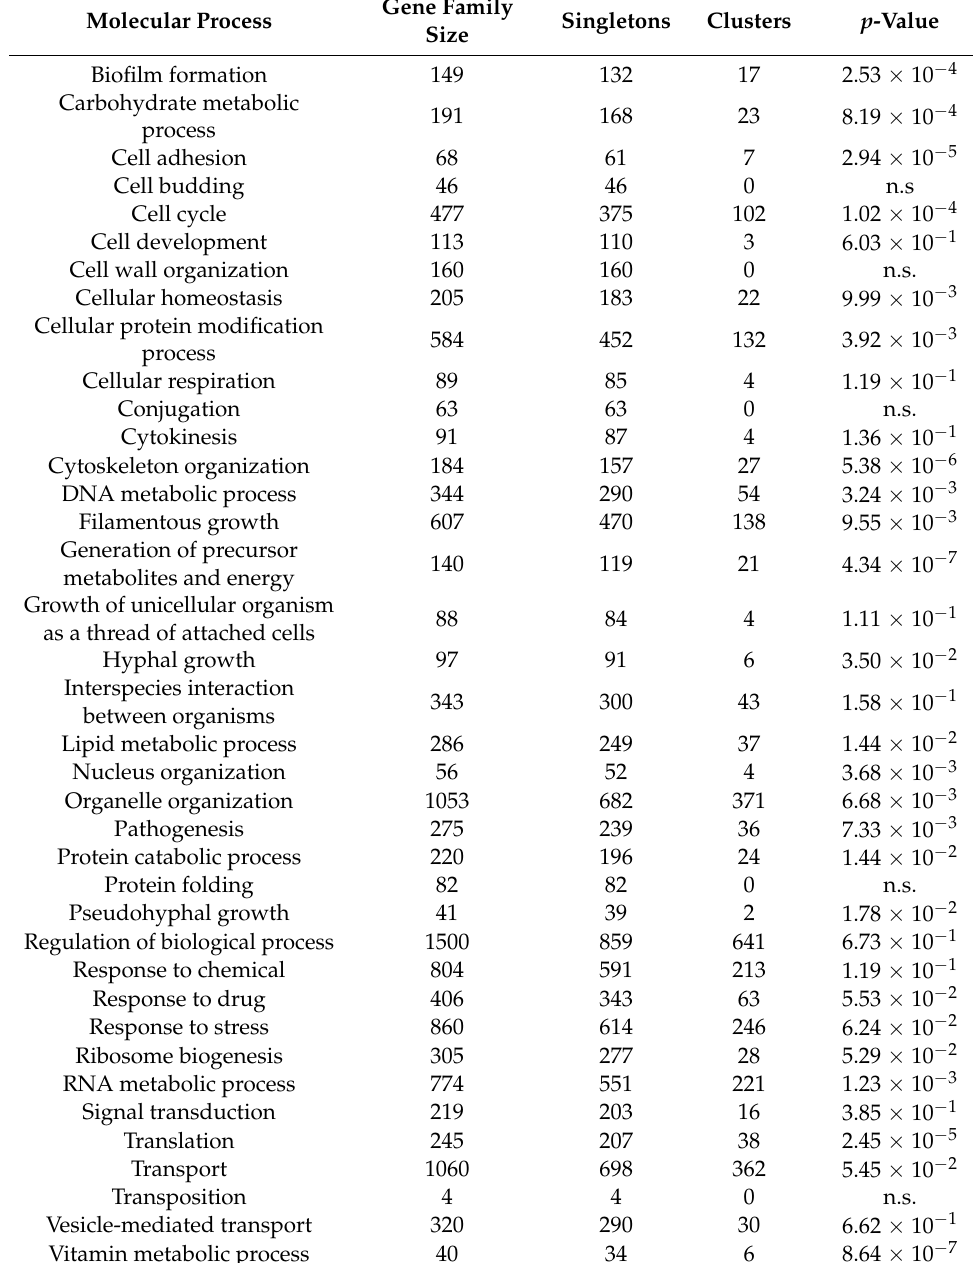
Table 1. Gene Clustering within a Shared Molecular Process in Candida albicans. Molecular